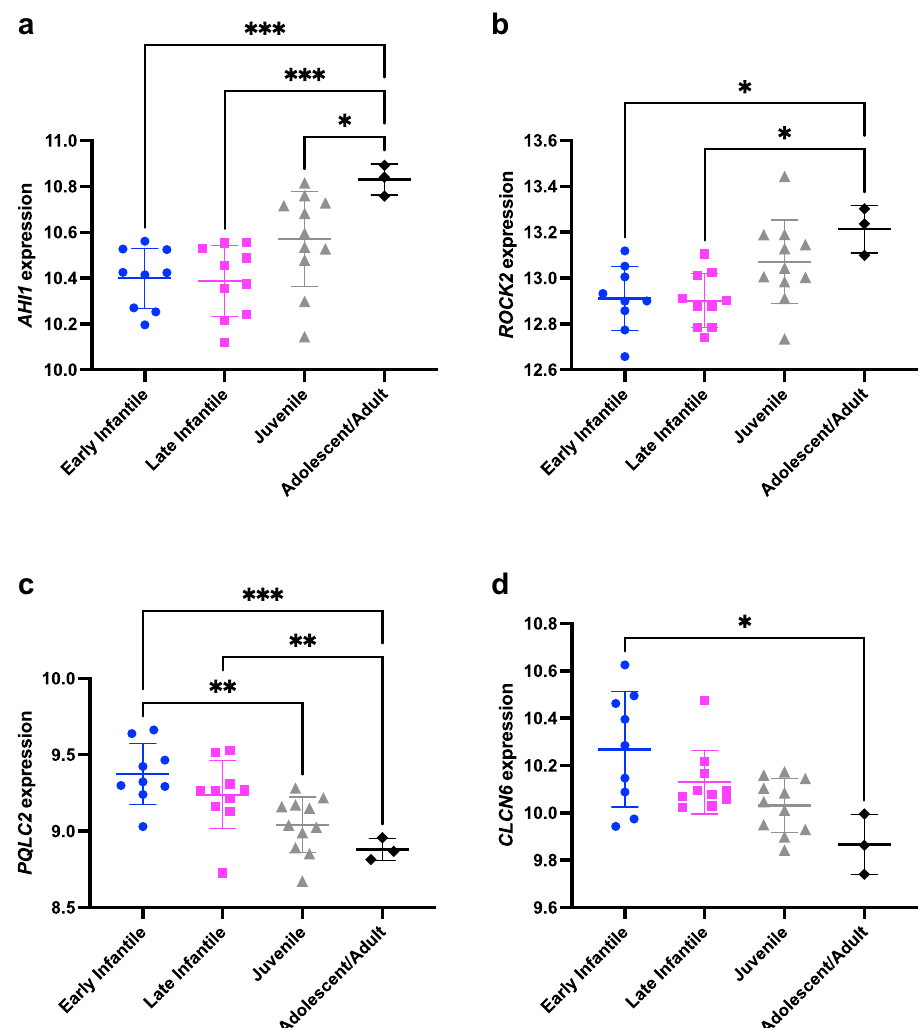
Figure 3. Gene expression significantly correlates with age of neurological disease onset. Four representative genes with significant correlation with the age of first neurological symptom are shown: ( a ) AHI1 , ( b ) ROCK2 , ( c ) PQLC2 , and ( d ) CLCN6 . The graphs show scatter plots of expression for each gene in each patient (variance stabilized read counts, y-axis) plotted against the age of first neurological symptom for each patient (N = 33). Patients are divided into four groups based on age of onset categories that have been previously described 86 , as follows: early infantile (2 months–2 years, N = 9), late infantile (3–6 years, N = 10), juvenile (7–15 years, N = 11), and adolescent/adulthood (> 15 years, N = 3). AHI1 and ROCK2 show direct correlation with age of first neurological symptom, while PQLC2 and CLCN6 show inverse correlation. Gene expression values are significantly different across age groups, as calculated by Welch ANOVA (p < 0.05 for all genes) followed by Dunnett’s multiple comparisons test (p values as indicated; *p < 0.05, **p < 0.01, ***p <